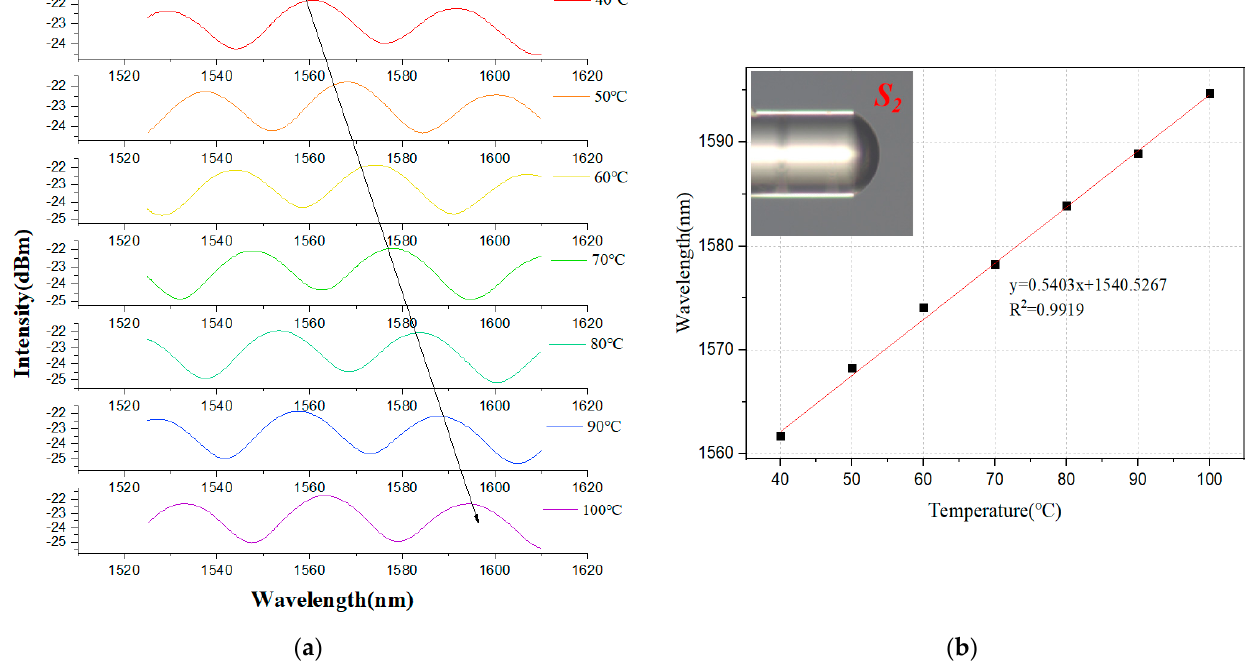
Figure 7. ( a ) The temperature (ranging from 40 to 100 ◦ C, in strides 10 ◦ C) response interference spectrum of S 2 (Ecoflex0030/PDMS); and ( b ) temperature sensitivity of S 2